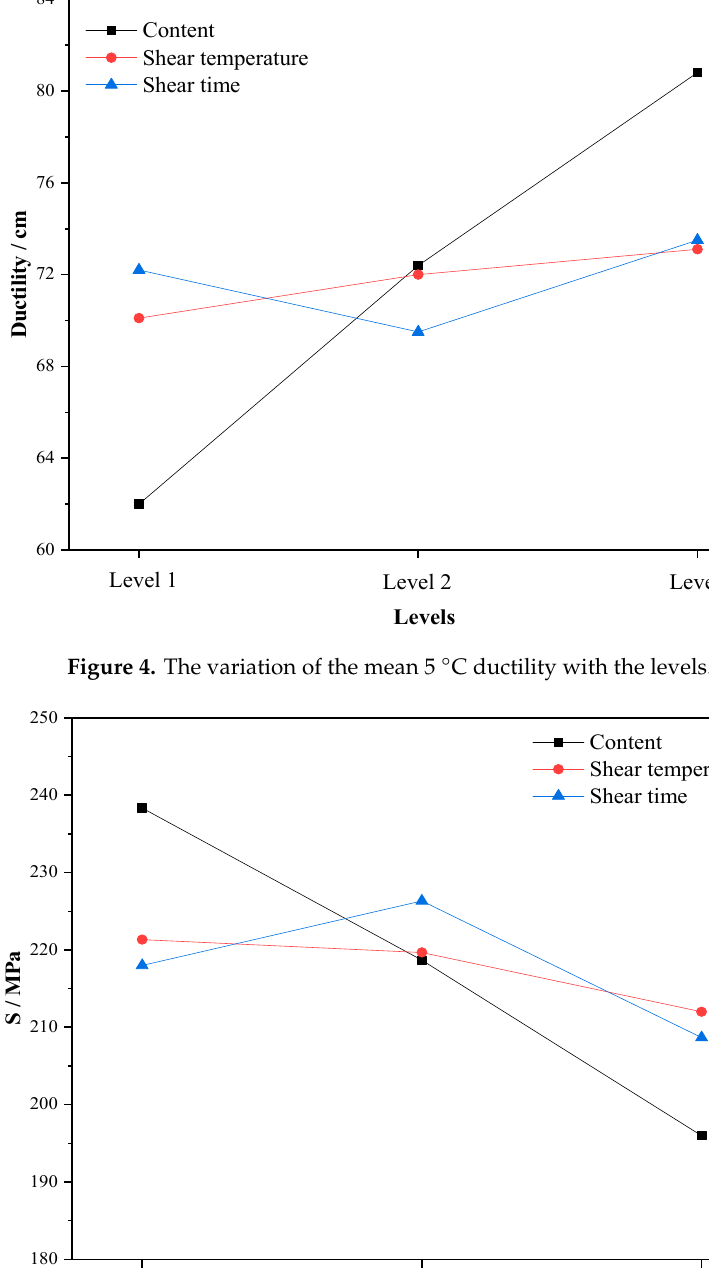
Figure 6. The variation of the mean m with the levels. 3.3. Influence Extent of Different Factors on the Properties of A-G-R To obtain the weight and significance of each factor on the performance of A-G-R, the range analysis and variance analysis were carried out to determine the influence extent. The range is defined as the difference between the maximum average value and the minimum average value at each level under the same factor. The range reflects the influence extent of the factor on the performance index, and the larger the range is, the greater the influence extent of this factor is. In Table 6, it can be seen that the order of influence extent of each factor on three high temperature performance indices of A-G-R was as follows: crumb rubber content > shear temperature > shear time. The order of influence extent of each factor on three low temperature performance indices was as